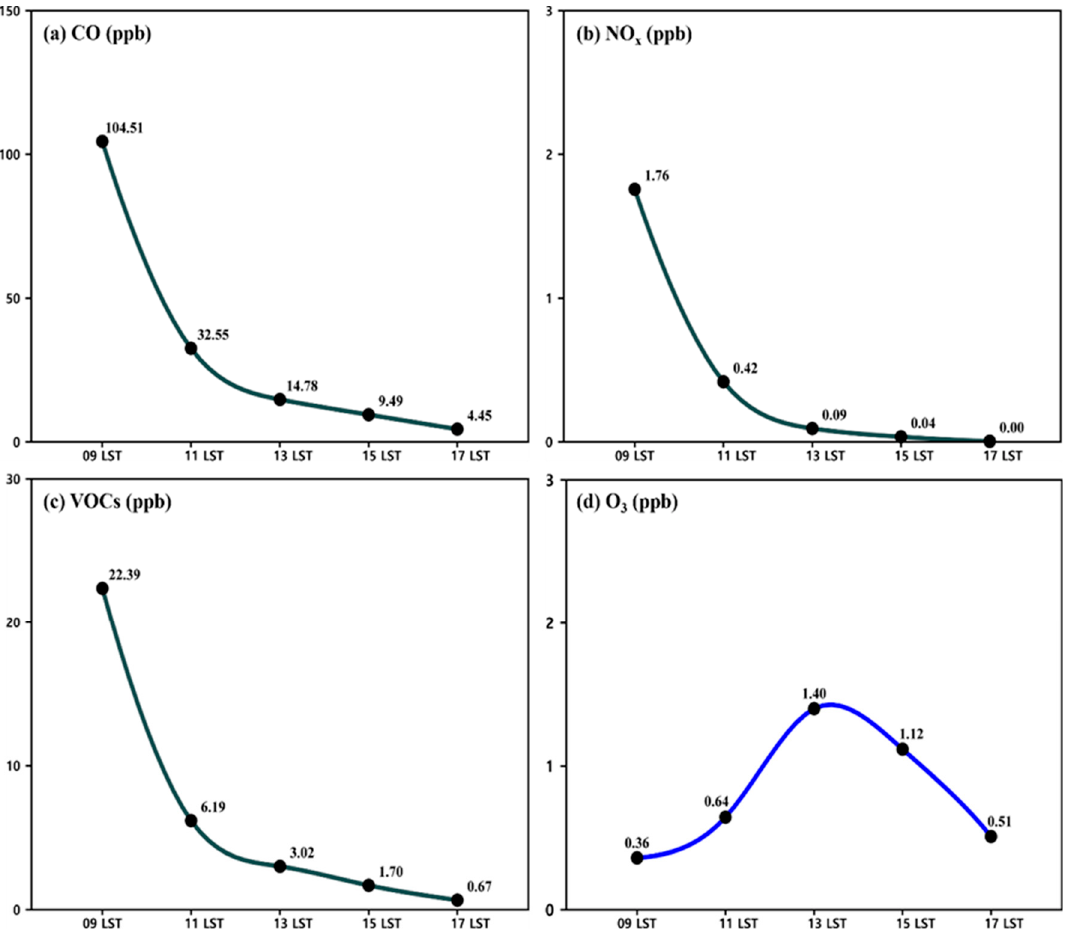
Figure 7. Changes in concentration of primary pollutants (( a ) CO, ( b ) NO x , ( c ) VOCs, and ( d ) O 3 ) at the central locations in the wildfire plume (Figure 5) during the analysis period (FINN_pbl – BASE) .